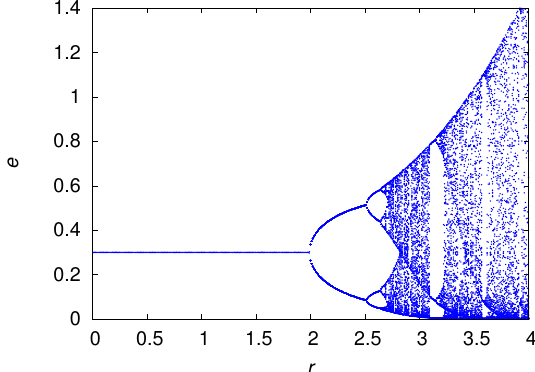
Figure 1. Bifurcation diagram for the local population dynamics (5)–(8) with parameters α = 0.1, δ = 0.01 and ρ = 0.005. The points on the y-axis show the values of the engineer density visited asymptotically from all initial conditions with e 0 >